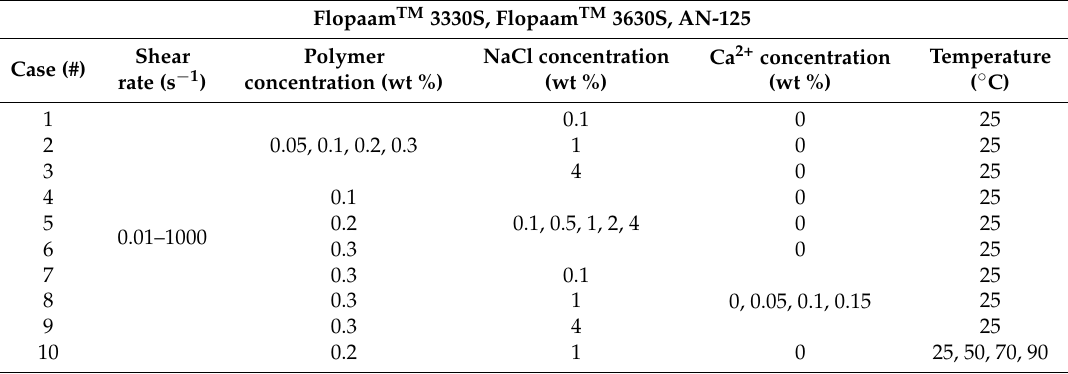
Table 2. Conditions of polymer